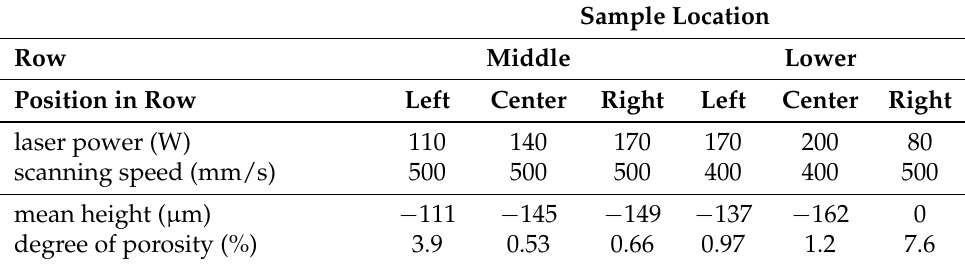
Table A1. Parameters of processing (two top lines) and characterization (two bottom lines) of samples shown in Figure 14. For all samples, hatch distance = 70 µ m, layer thickness = 50 µ m. A hatch distance is the difference between adjacent tracks. The chosen parameters lead to 142 hatches per layer for one cube. The metallic powder used in the investigations was TruForm™ 718 (PraxAir), a high-strength, corrosion-resistant nickel-chromium material with a melting temperature of 1260–1336 ◦ C. The values are taken from layer 20, the center of the cubes. For an easier overview, the level of the sample in the lower right (highest degree of porosity) was set to the value 0. The sample on the upper left of Figure 14a was not taken into account because the z-values do not appear plausible due to the large distance between the melted tracks (compare Figure